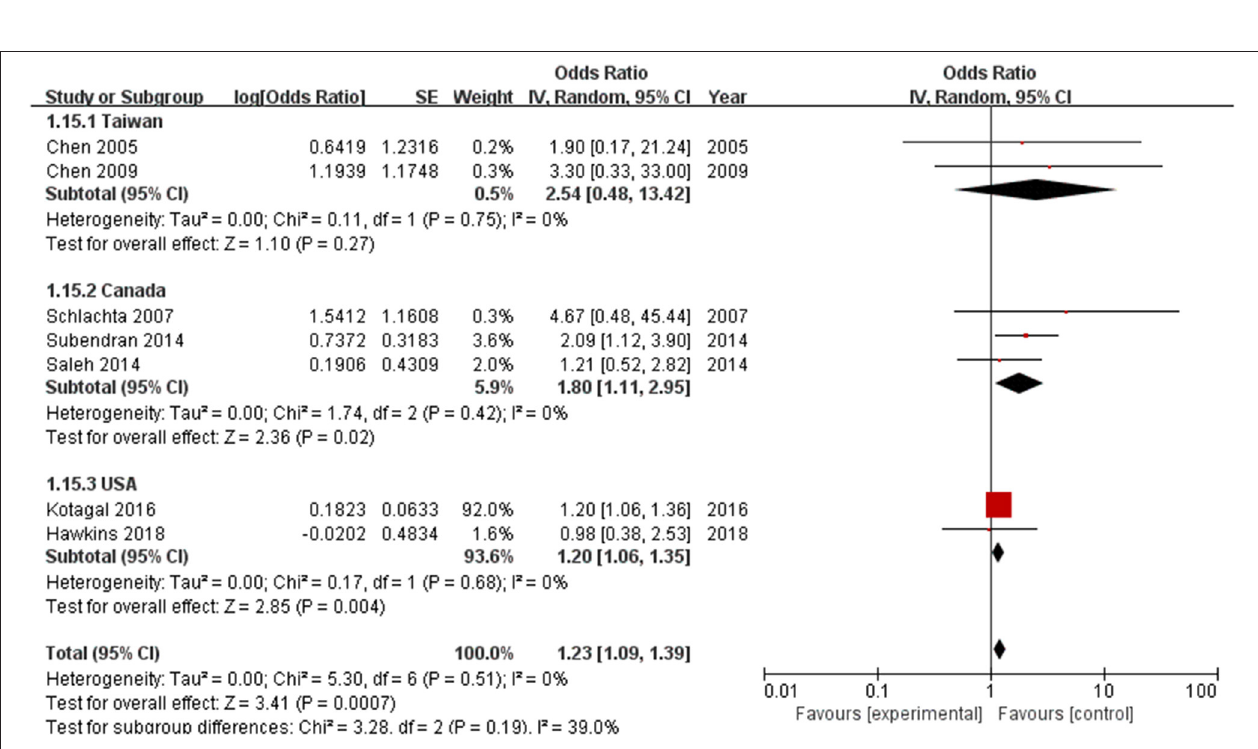
FIGURE 6 | Forest plots of subgroups according to different geographical location.